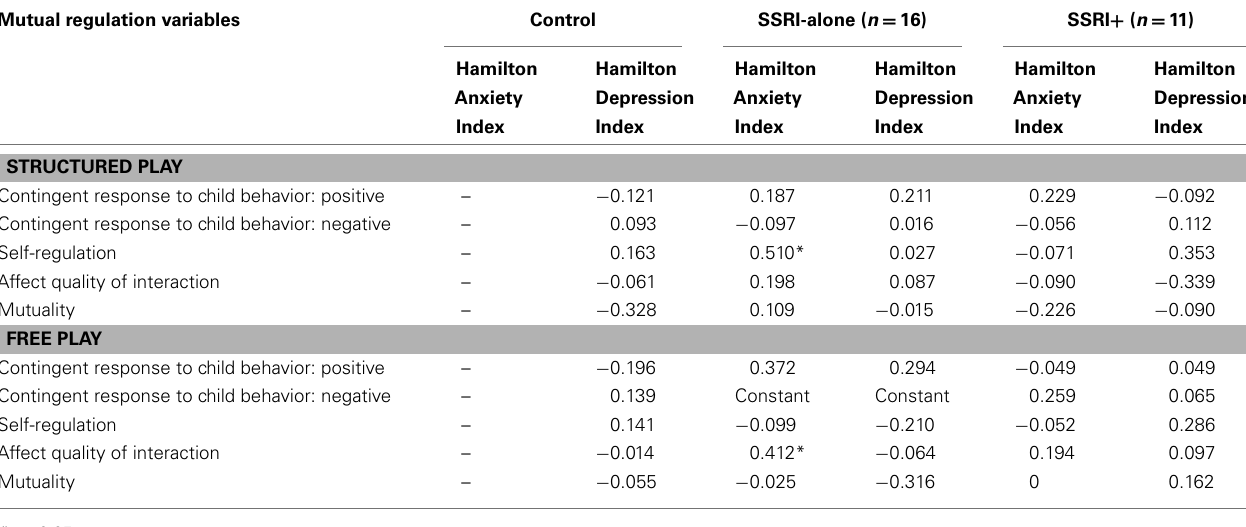
Table 6 | Kendall’s tau b correlation coefficients between mutual regulation variables during both interaction sequences at 8months and HAM-A and HAM-D indices at 8months for SSRI-alone and SSRI + groups and at 2months for control group.